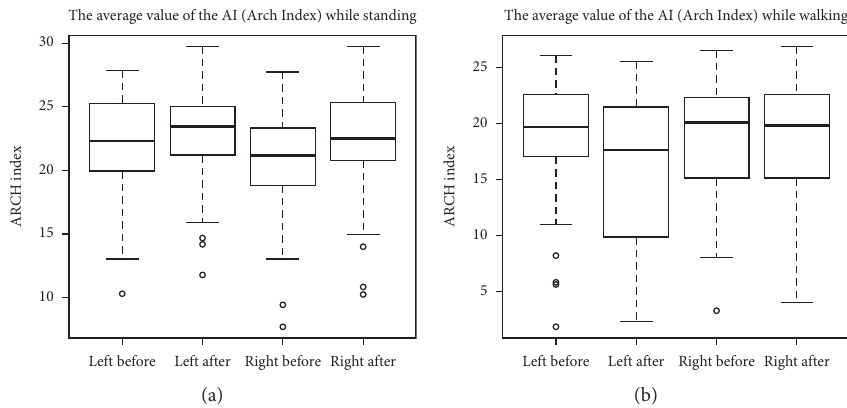
Figure 10: (a) Distribution of the AI before and after stabilizing the mandible in a new position using a temporary silicone occlusal splint; the examination was performed in the standing position. (b) Distribution of the AI before and after stabilizing the mandible with a temporary silicone occlusal splint; the examination was performed during walking.